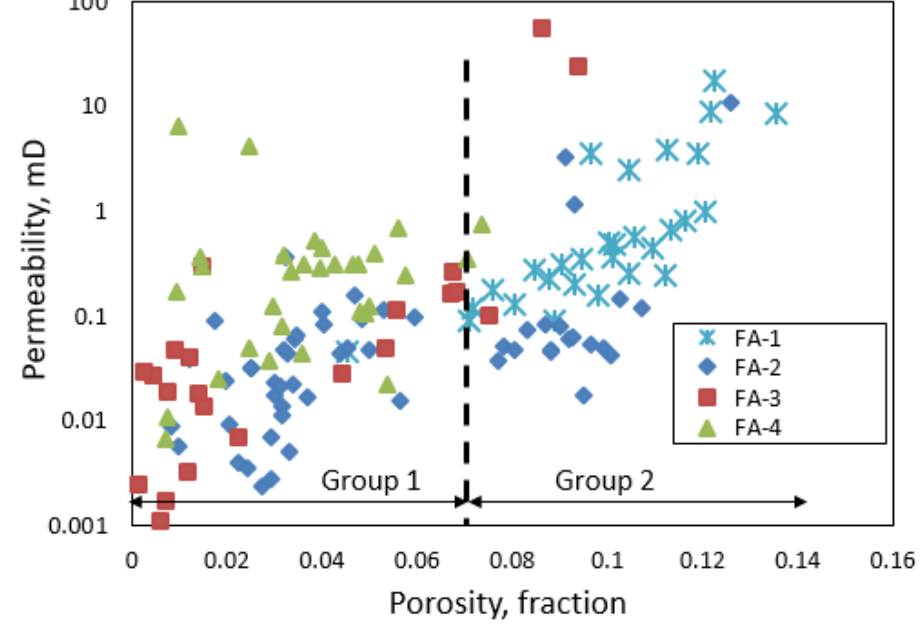
Figure 7. Cross-plot of helium porosity and helium permeability of 140 rock samples classified based on facies associations.